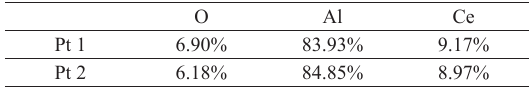
Table 2. Results of EDS analysis for O, Al and Ce (weight %) of AA1230 clad treated with CeHT.